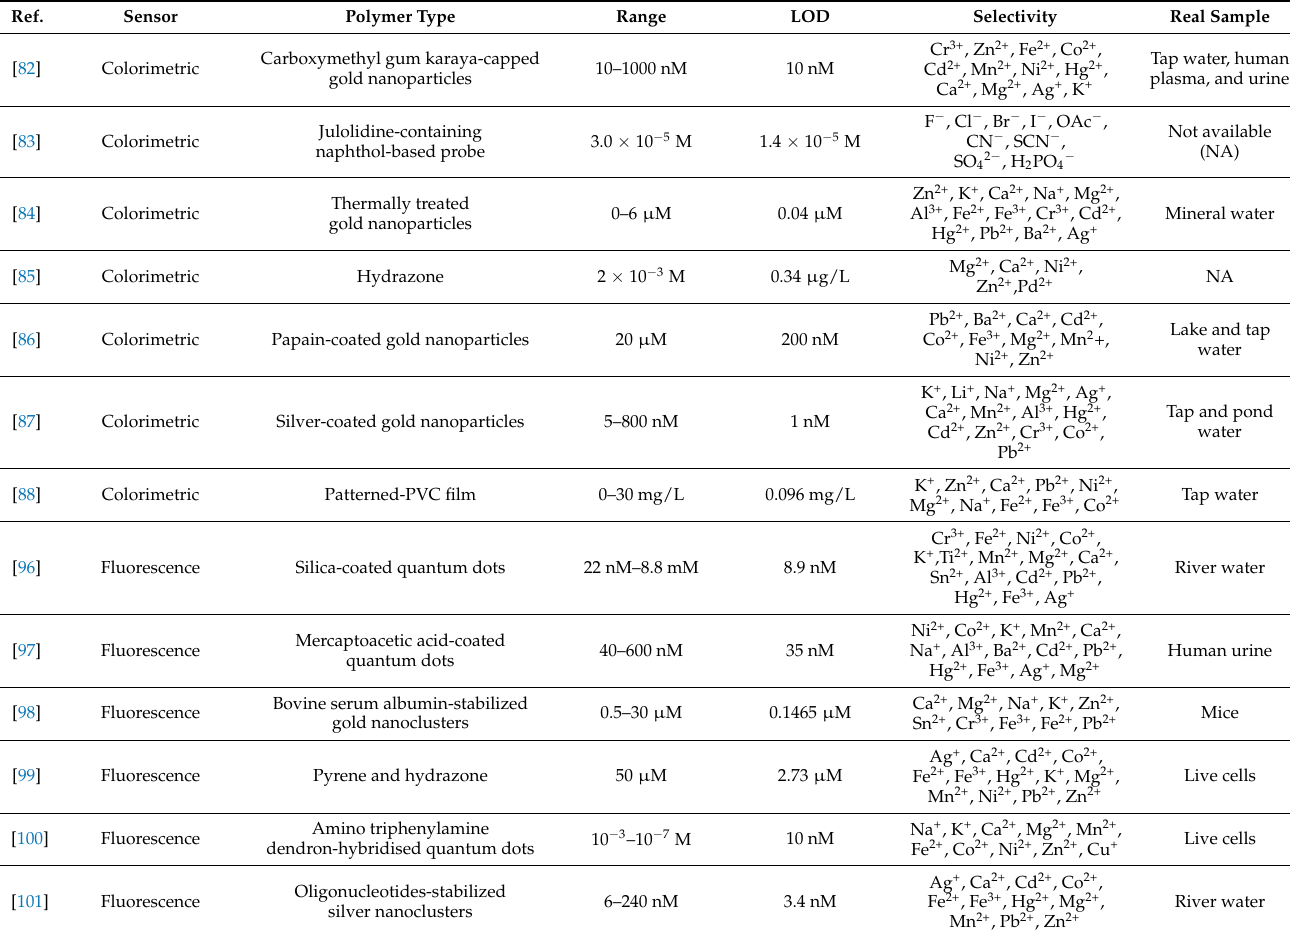
Table 1. Comparison of different optical sensors for Cu 2+ ion